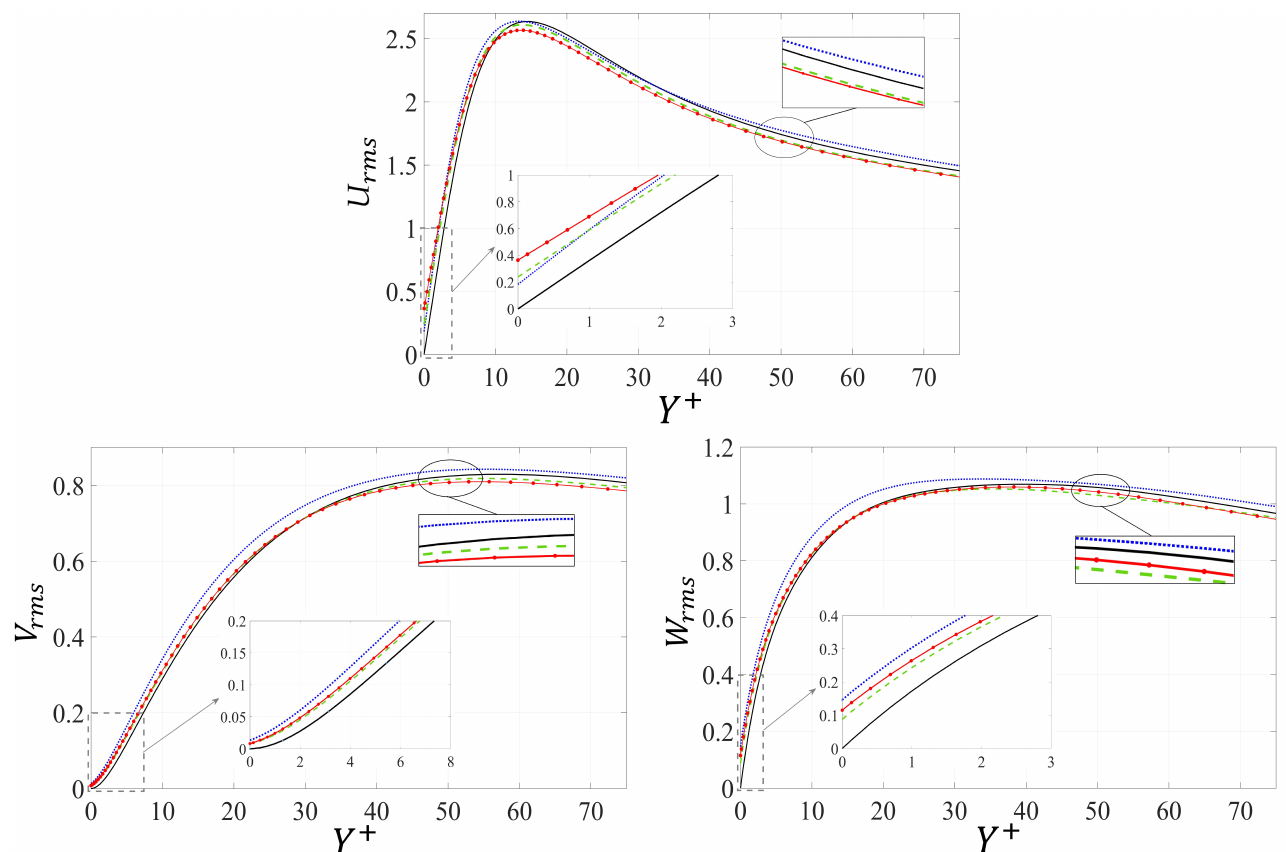
Figure 14. Root-mean-squares of the primary fluctuations over different permeable walls. Close-ups of the profiles in the neighborhood of the permeable wall and in the logarithmic layer are provided. The cases shown are: (solid black line) smooth channel; (dotted blue line) substrate TC 5 ; (dashed green line) substrate LC 5 ; (red line with markers) substrate LM 5